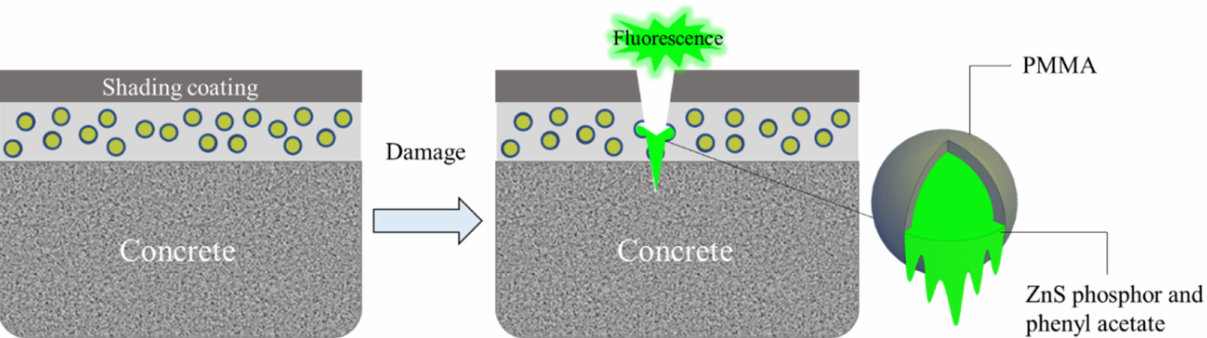
Figure 7. Schematic diagram of damage indication.